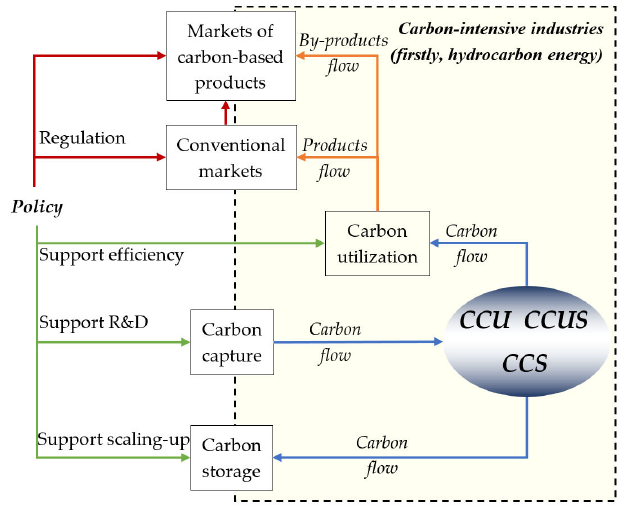
Figure 9. Conceptual framework for CO 2 sequestration